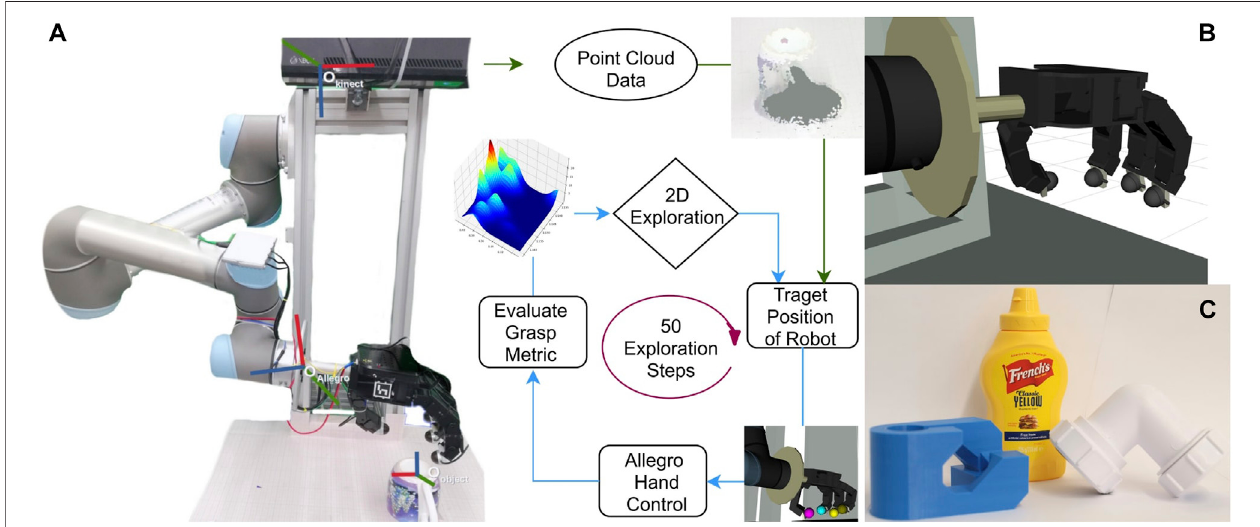
FIGURE 1 | (A) Overview of the setup and the exploration pipeline. The setup includes a UR5 robot arm, an Allegro robot hand equipped with Optoforce 3D force sensorsinthe fi ngertips, aKinect RGB-Dsensor. (B) TheAllegro handvisualised withtheRVIZsoftware. (C) Thethree complex-shaped objects usedintheexperiment.